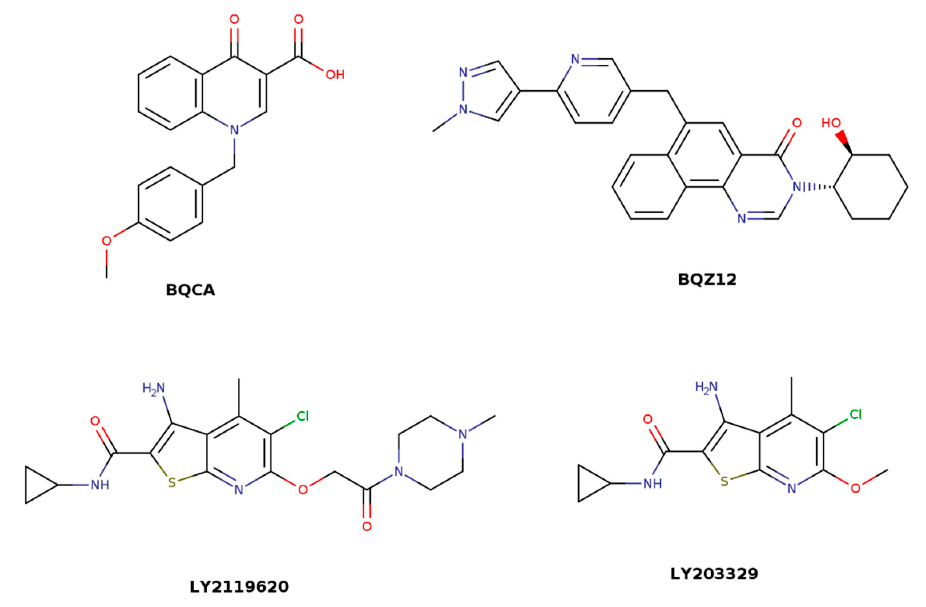
Figure 4. Structures of M 1 -selective benzyl quinolone carboxylic acid (BQCA), BQZ12, M 2 -selective LY2119620, and M 4 -selective LY2033298 allosteric modulator.